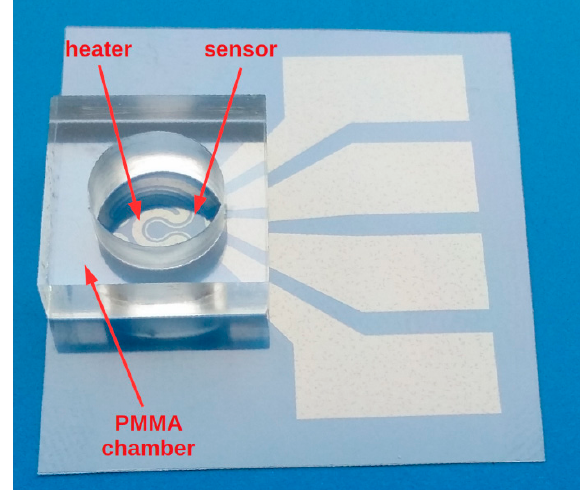
Figure 7. Heater-sensor structure integrated with chamber.